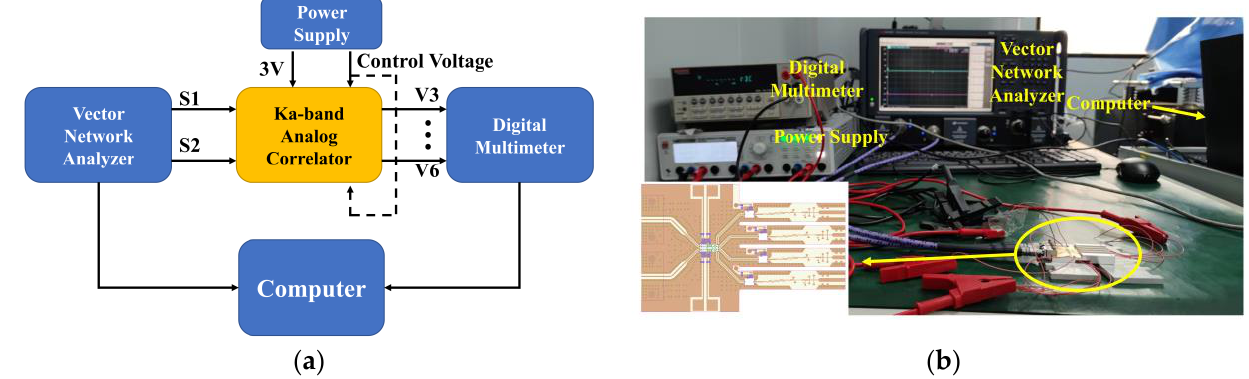
Figure 11. The block diagram and the test site of the single-frequency measurement: ( a ) measurement block diagram; ( b ) test site.